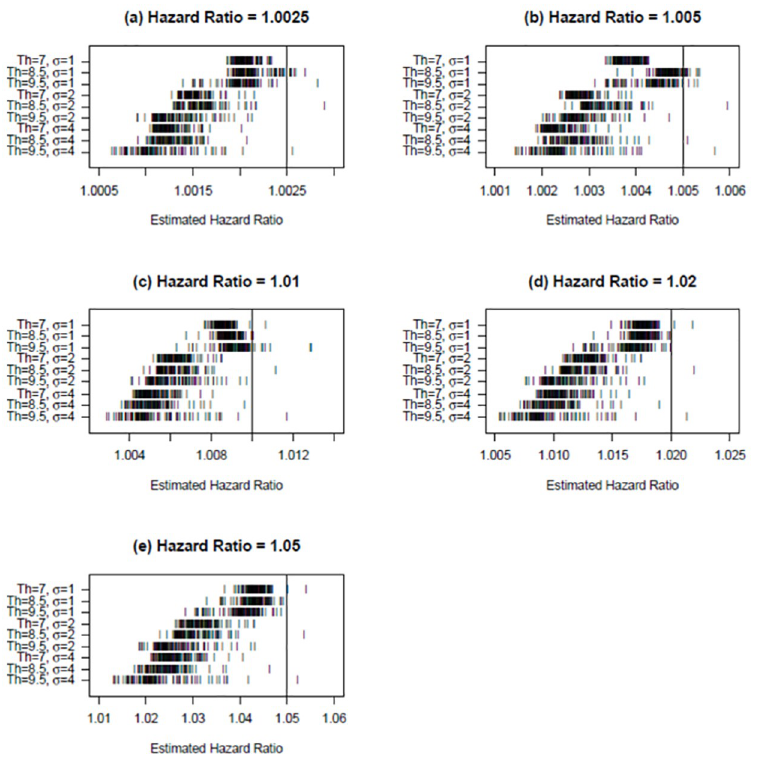
Fig 3. Attenuation in hazard ratios under varying amounts of measurement error and different “true” C-R thresholds.